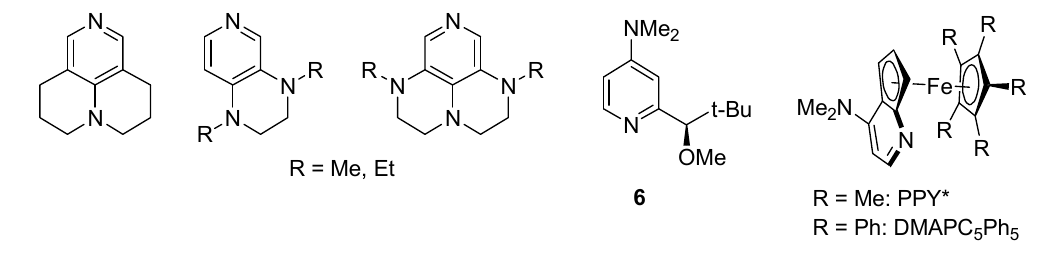
Figure 7. Electron ‐ rich pyridines as nucleophilic catalysts.